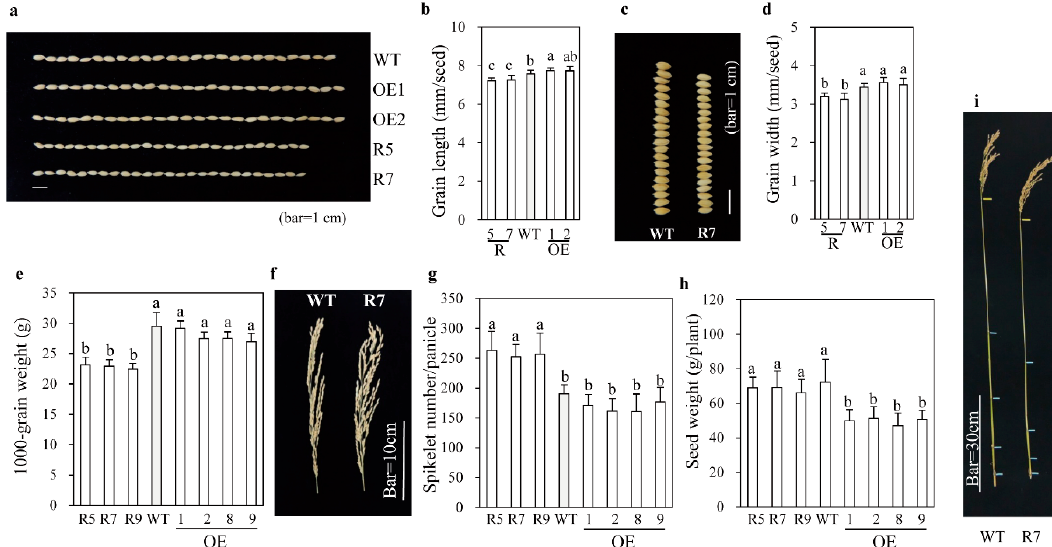
Figure 2. Rice grain and panicle morphology. ( a ) Photograph showing lengths of grains from WT, OE, and snat2 lines. ( b ) Grain lengths ( n = 200). ( c ) Photograph showing widths of grains from snat2 line and WT. ( d ) Grain widths ( n = 200). ( e ) 1000-grain weights ( n = 4). ( f ) Representative panicle morphologies. ( g ) Spikelet numbers ( n = 20). ( h ) Seed weights ( n = 10). (i) Culm length of adult rice.